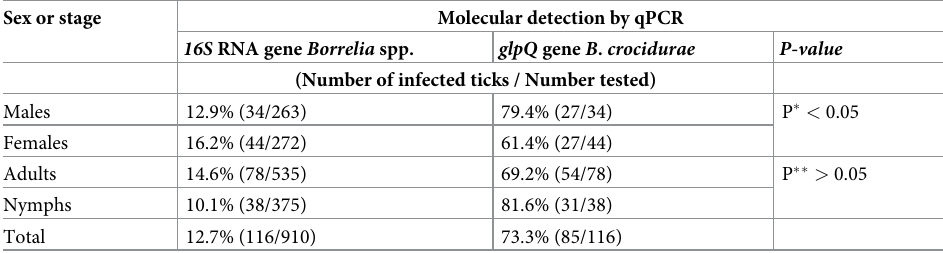
Table 1. Prevalence of Borrelia infection in O . sonrai ticks in the Niakhar district in Senegal. Sex or stage